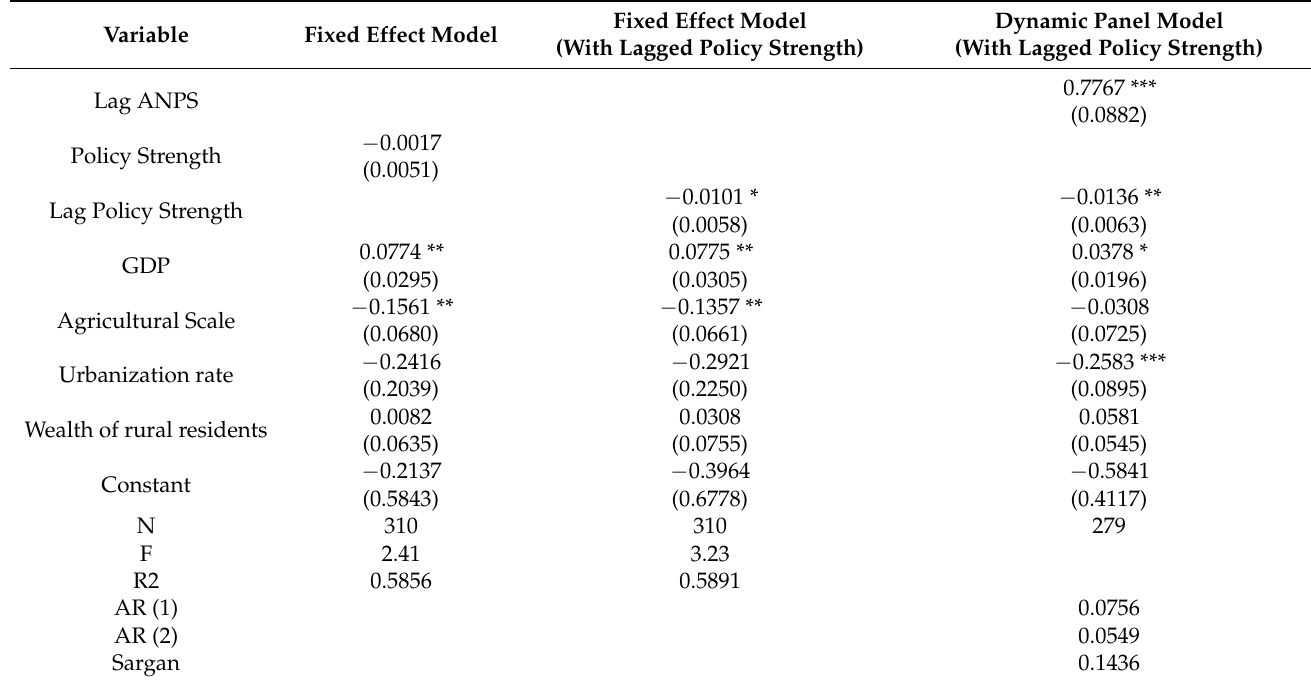
Table 5. Regression results of the impact of policy strength on ANPS